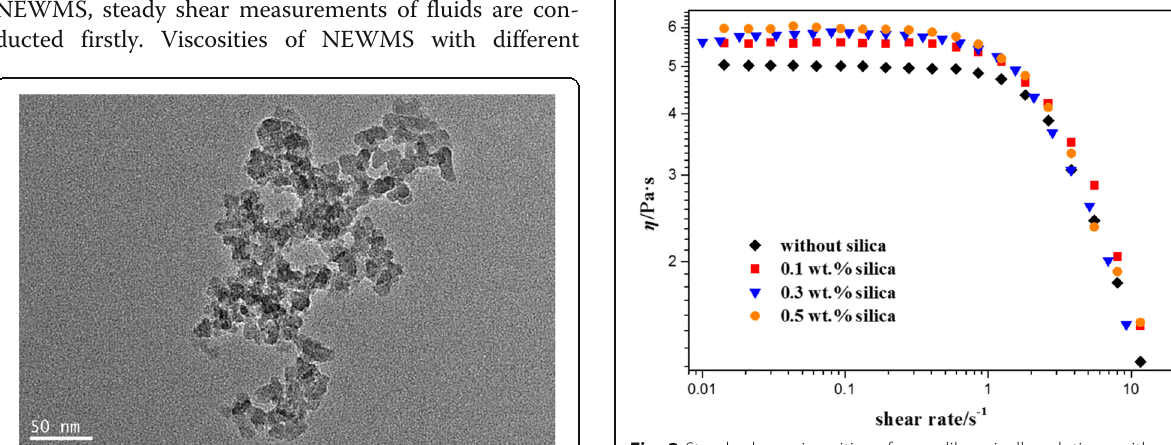
Fig. 2 Steady shear viscosities of wormlike micelle solutions with addition of different silica mass fraction at 25 °